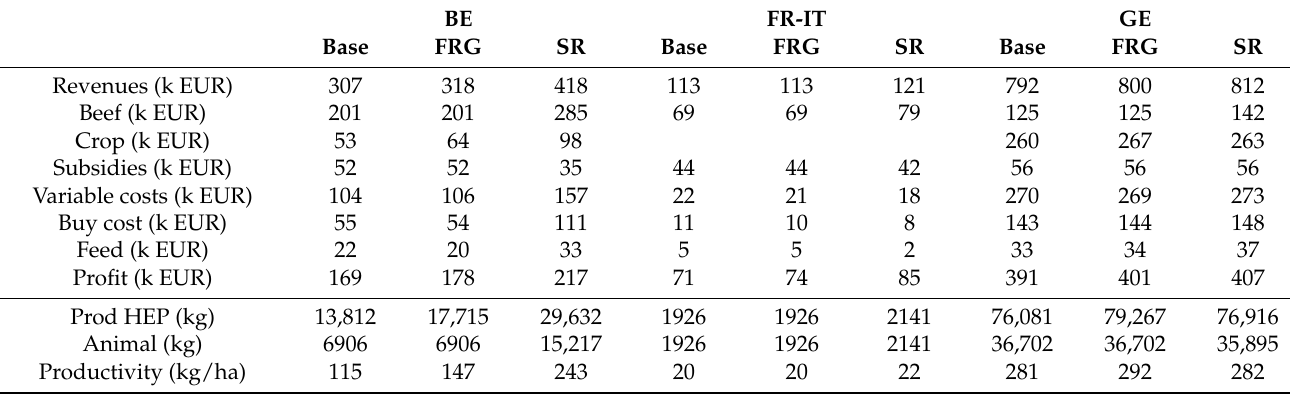
Table A2. Economic and social results for the farm of interest in each